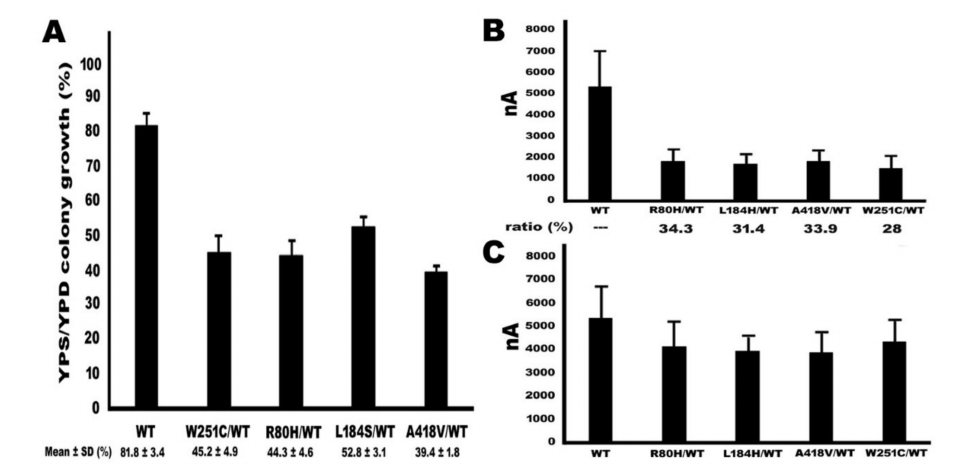
Figure 7. Analysis of the e ff ects of the TMPRSS3 mutant proteins on TMPRSS3WT by co-expression studies in the sGASP system and Xenopus oocytes. ( A ) Yeast (KSY01 strain) was transformed with substrate and equal amounts expression plasmids of TMPRSS3WT and TMPRSS3 mutants, as indicated and plated on YPD and YPS plates. Quantitative assay of growth rate was calculated by dividing the number of colony on YPS plates by the number of colony on YPD plates. All values are expressed as the mean ± SD of duplicate determinations ( n = 5). ( B ) Rat ENaC subunit and equal amounts of TMPRSS3WT and TMPRSS3 mutant cRNA co-injected into Xenopus oocytes for electrophysiological ratios were calculated ( n ≥ 10). These results indicated that the Na + currents were under 2000 nA in the four heterozygous mutations group. Simultaneously, the ratios of Na + currents were calculated by dividing the currents of TMPRSS3 mutant by the currents of TMPRSS3WT. All of the four heterozygous mutation ratios were less than 40% function of TMPRSS3WT. ( C ) After trypsin treatment, the ENaC was significant activated, producing Na + currents in the heterozygous mutation